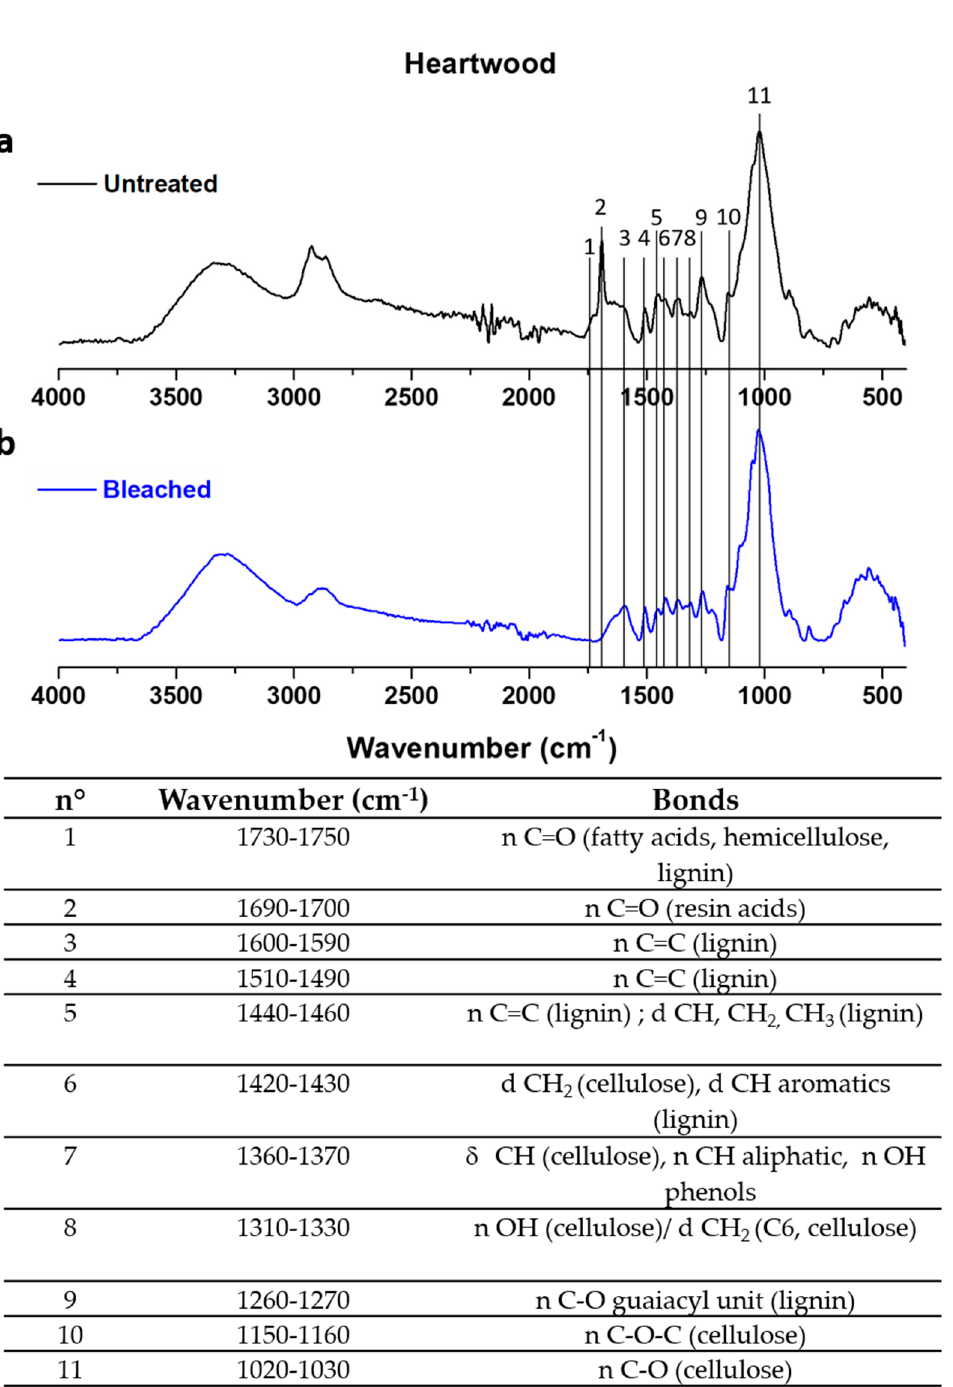
2 O 2 treated heartwood ( b ) powders and wavenum-